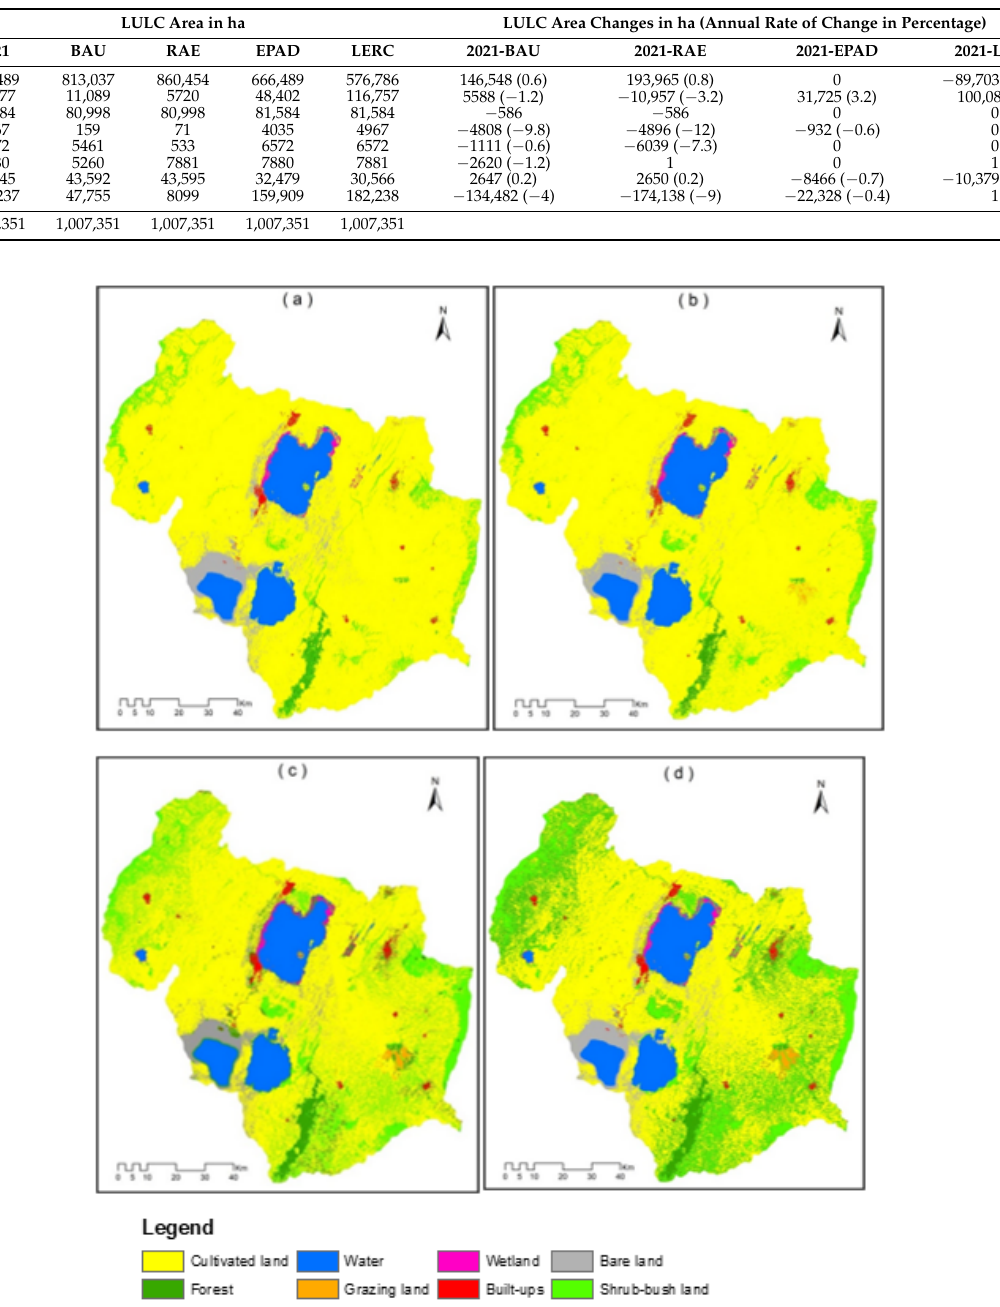
Table 2. LULC patterns under four different scenarios compared to base year 2021.